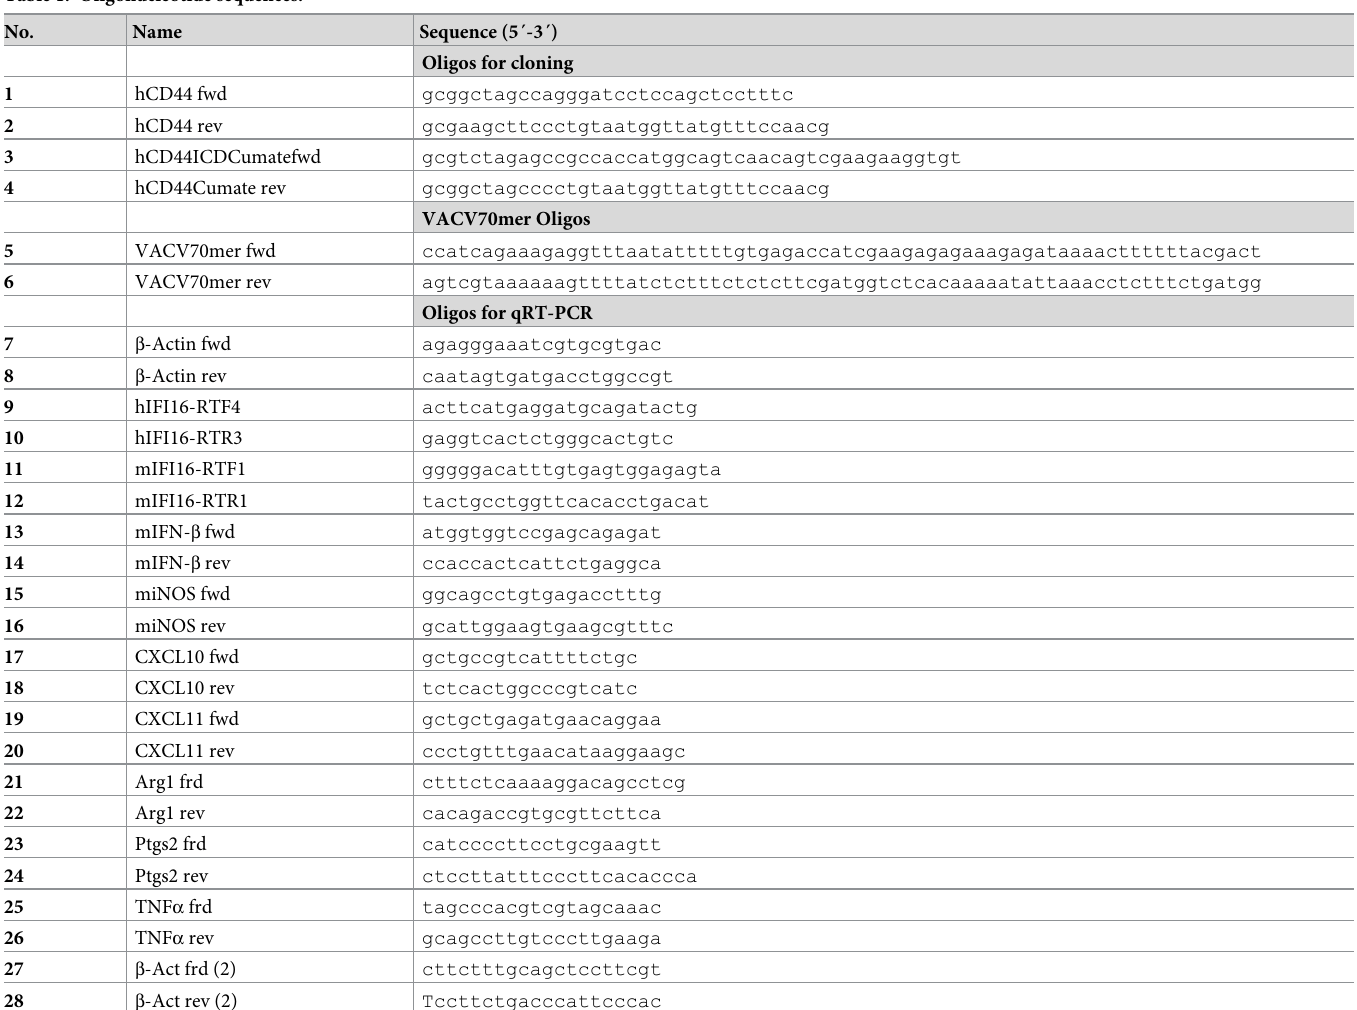
Table 1. Oligonucleotide